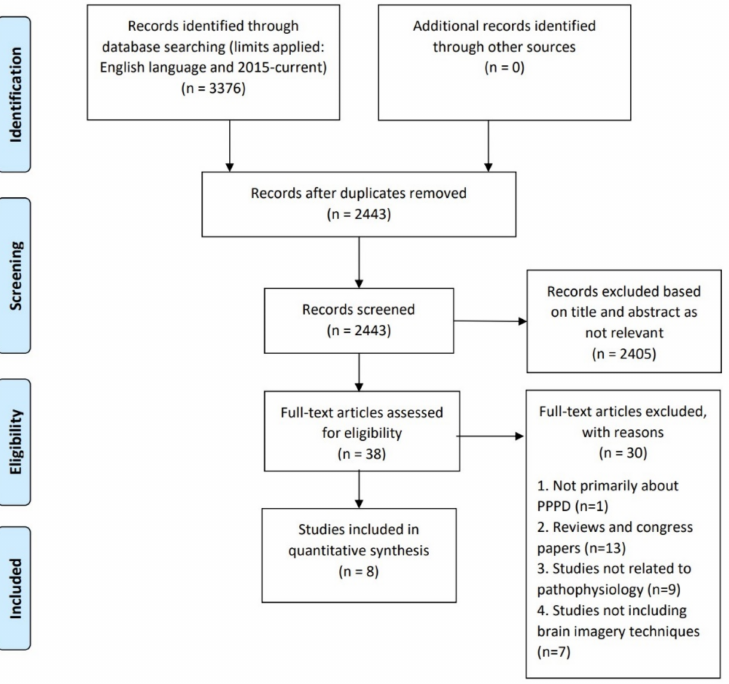
Figure 2. Flowchart depicting the paper selection procedure for the systematic review of neuroimag- ing data in PPPD patients (based on PRISMA 2009 Flow Diagram